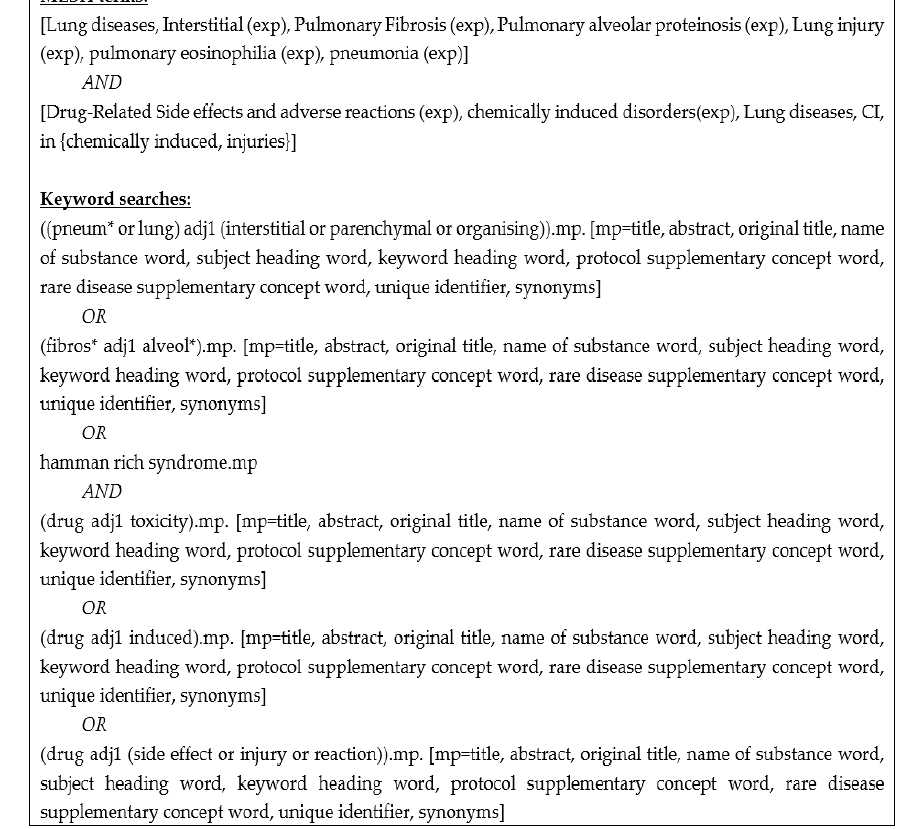
Figure 1. Search terms used in Medline, Embase and Cochrane Register of Controlled Trials.